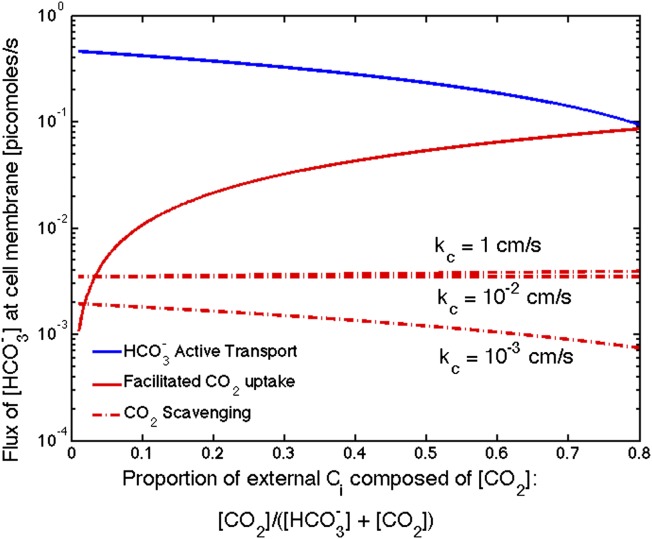
Size of the HCO3− flux in one cell from varying sources, as the proportion of CO2 to HCO3− outside the cell changes changes.We show results for three carboxysome permeabilities, kc, and only the scavenging is effected. Total external inorganic carbon is 15 μM, jc = 1 cm/s and αKα=1 cm/s. Scavenging is negligibly small for all values of kc shown. Unless there is very little HCO3− in the environment, HCO3− transport seems to be more efficient than CO2 facilitated uptake.